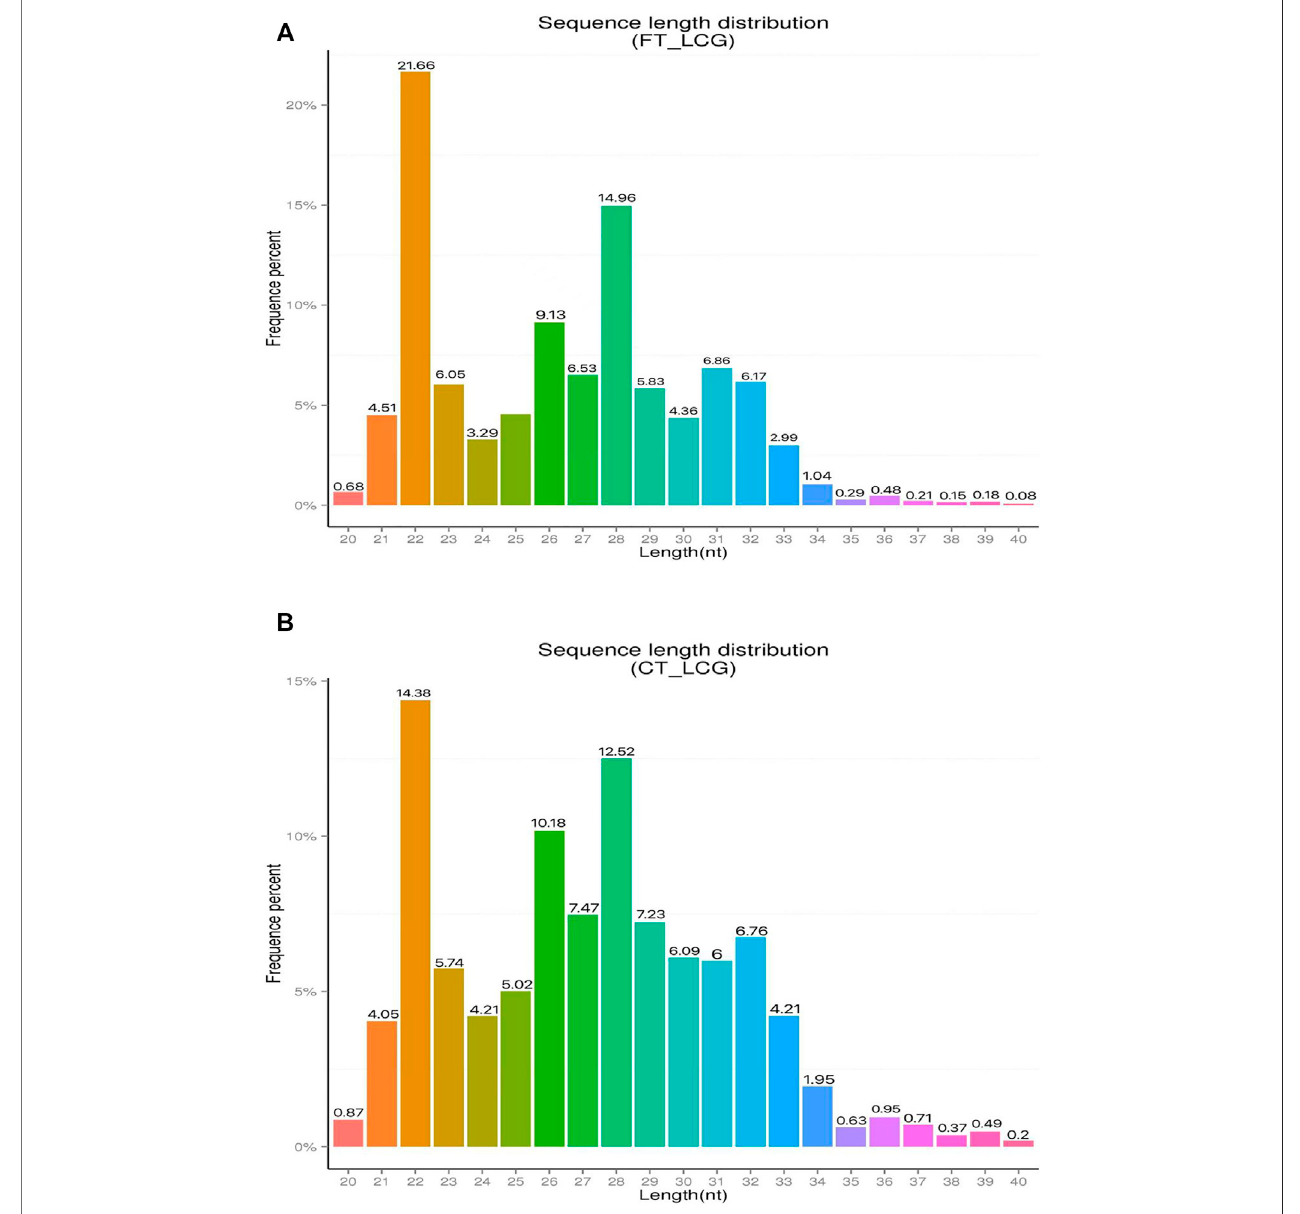
FIGURE 1 | Statistical chart of clean reads length enrichment of Ribo-seq in LCG. The abscissa is the enrichment length and the ordinate is the percentage of enrichment frequency. (A) Sample of fi ne LCG. (B) Sample of coarse LCG.